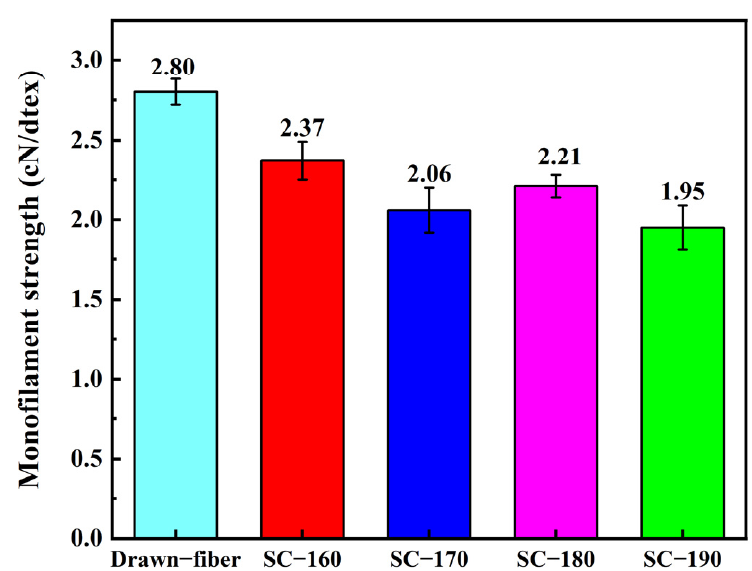
Figure 5. Monofilament strength of drawn − fi ber and SC − PLA fiber.